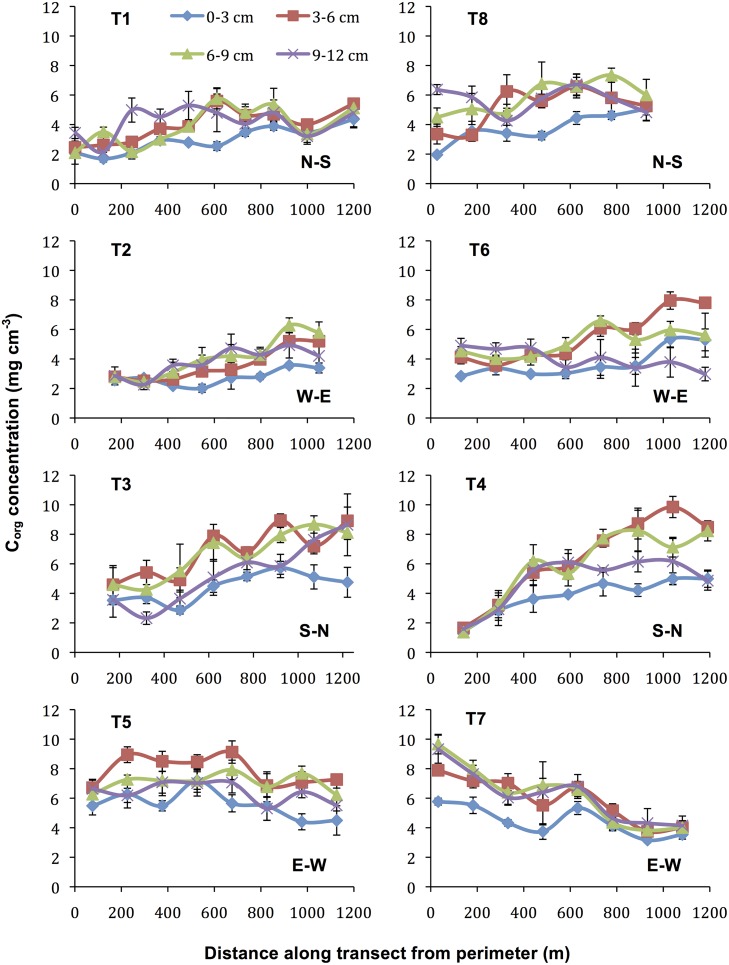
Sediment Corg concentrations along transects by bed depth interval.Error bars = SE.